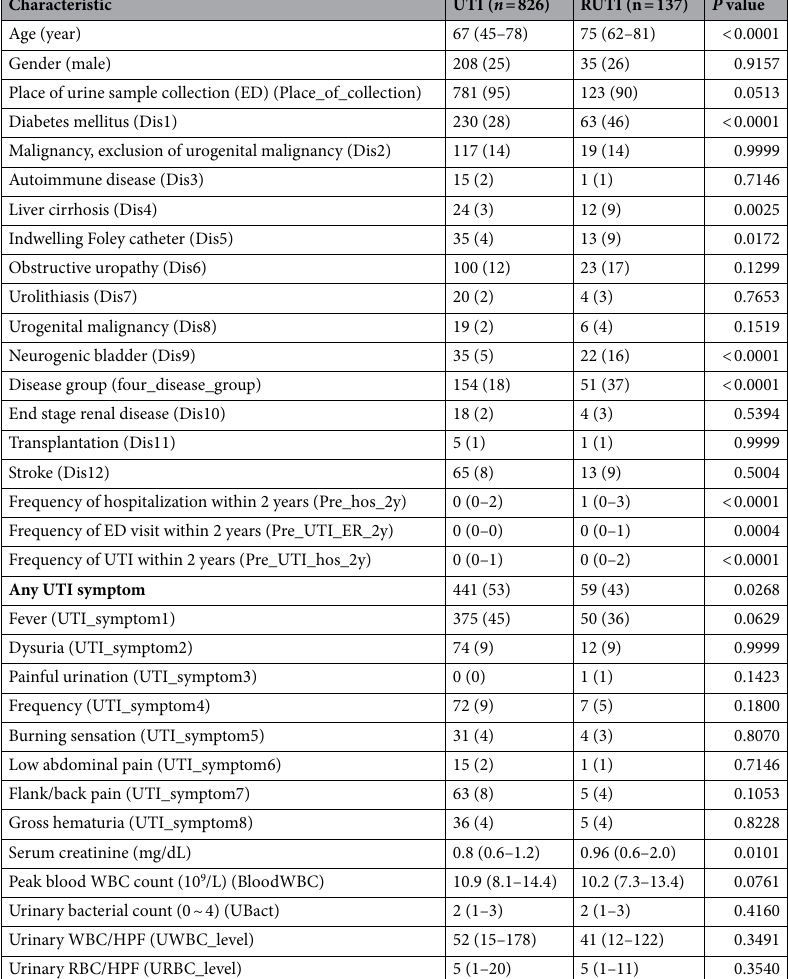
Table 1. Patient characteristics related to UTI and RUTI (sample size = 963) used in the first stage analysis. The name in the parentheses represents the label of the factor used in the machine learning models. Data are presented with median (interquartile range) or number (percentage). Abbreviations: UTI, urinary tract infection; RUTI, recurrent urinary tract infection; ED, emergency department; WBC, white blood cell; RBC, red blood cell; HPF, high power